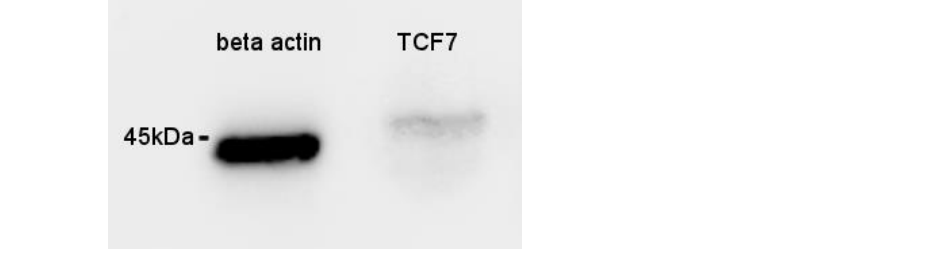
Figure A1. Western blot analysis confirming the specific binding of canine TCF7 by the antibody used.